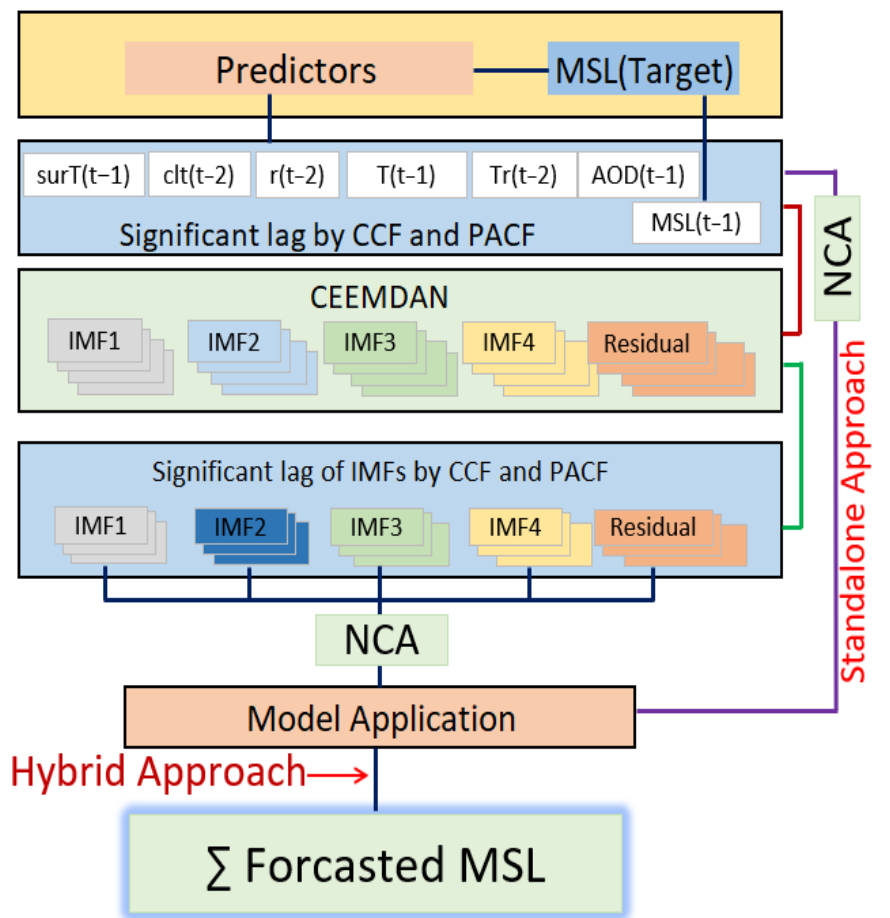
Figure 7. Methodological steps used in the model designing phase for the proposed hybrid CEEMDAN-CNN-GRU predictive models. Note: MSL = mean sea level, GRU = Gated Recurrent Unit, IMF = Intrinsic Model Function and NCA = Neighbourhood Component Analysis.